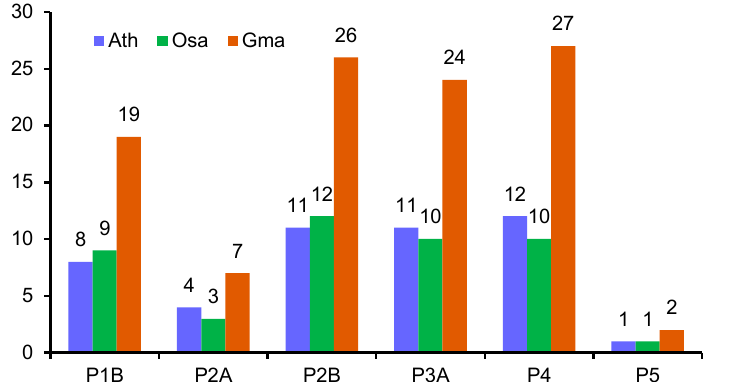
Figure 2. The number of genes encoding different P-type ATPase subfamilies in Arabidopsis (Ath), rice (Osa), and soybean (Gma).